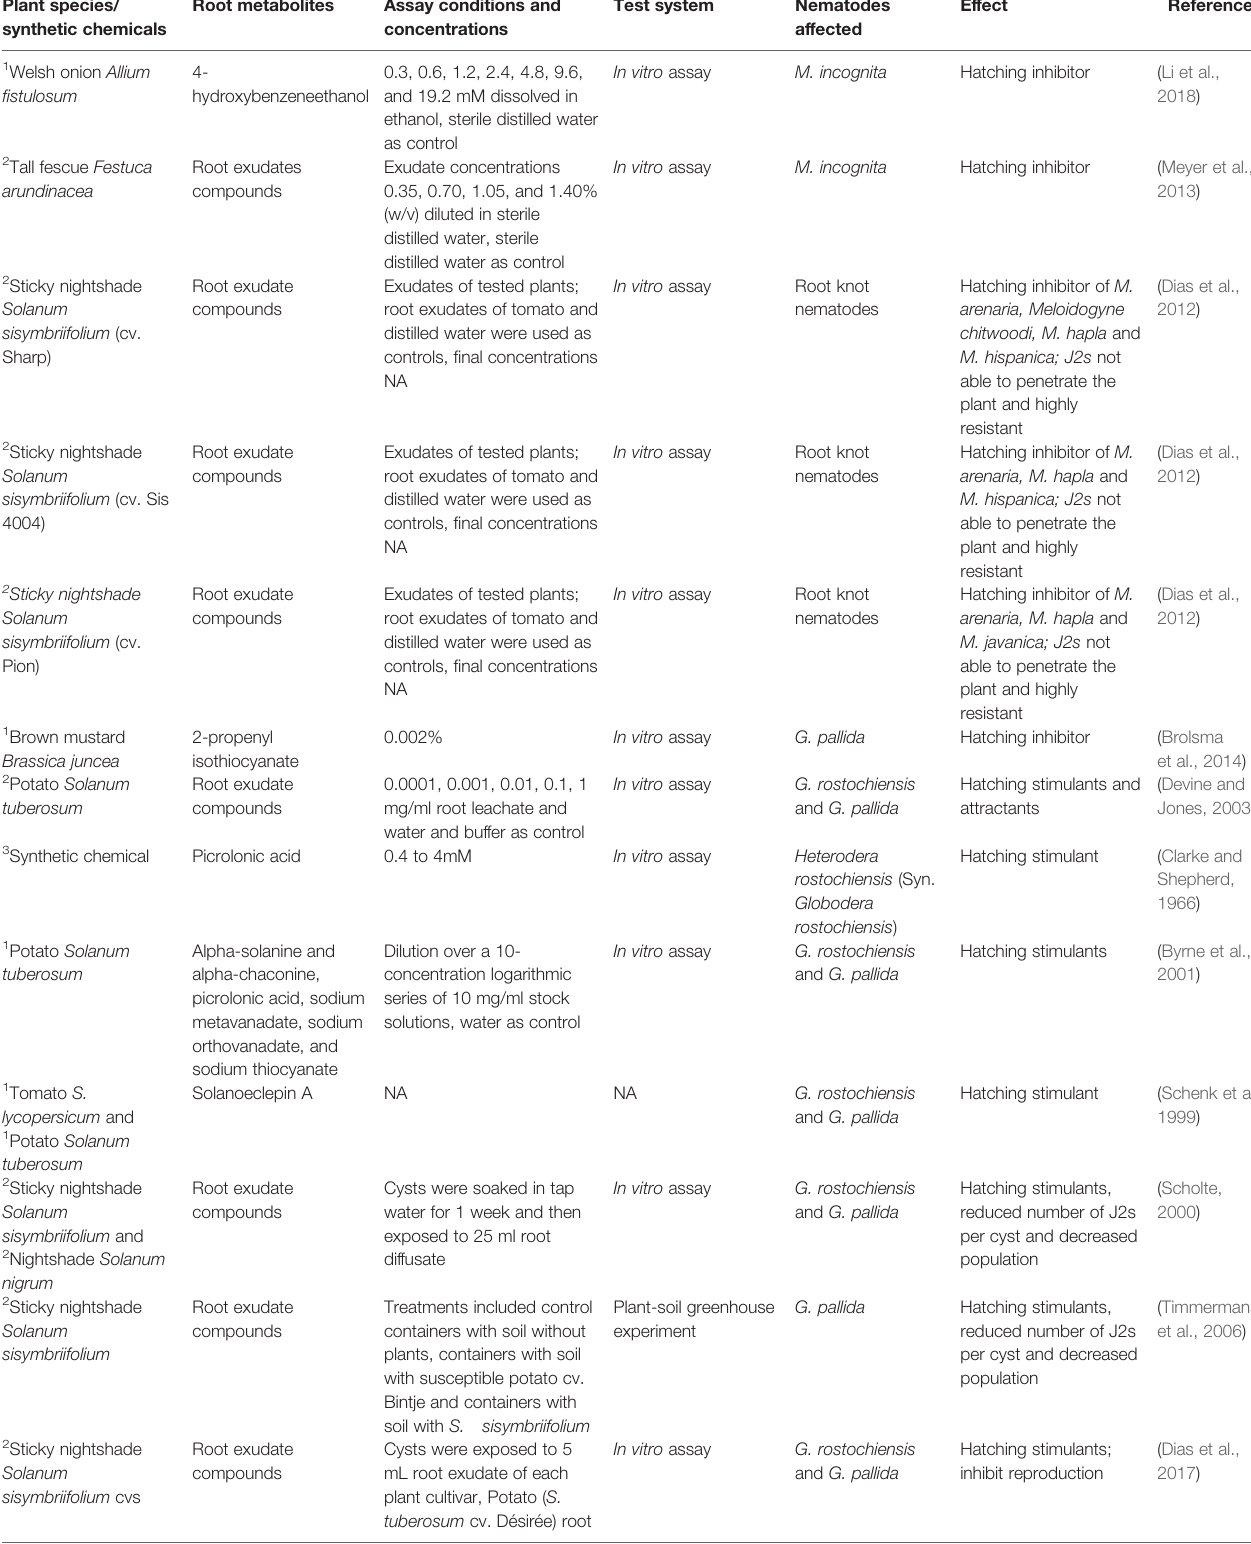
TABLE 3 | Root metabolites affecting nematode